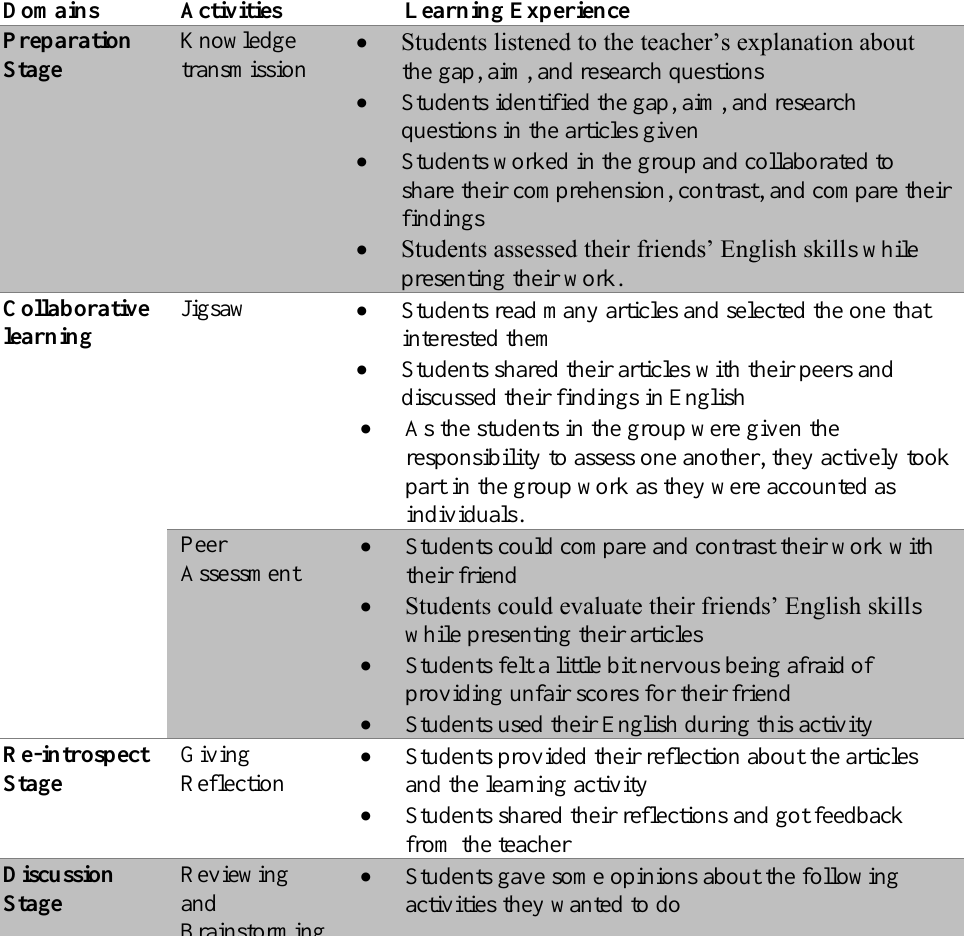
Table 2. Student’s Learning Experiences